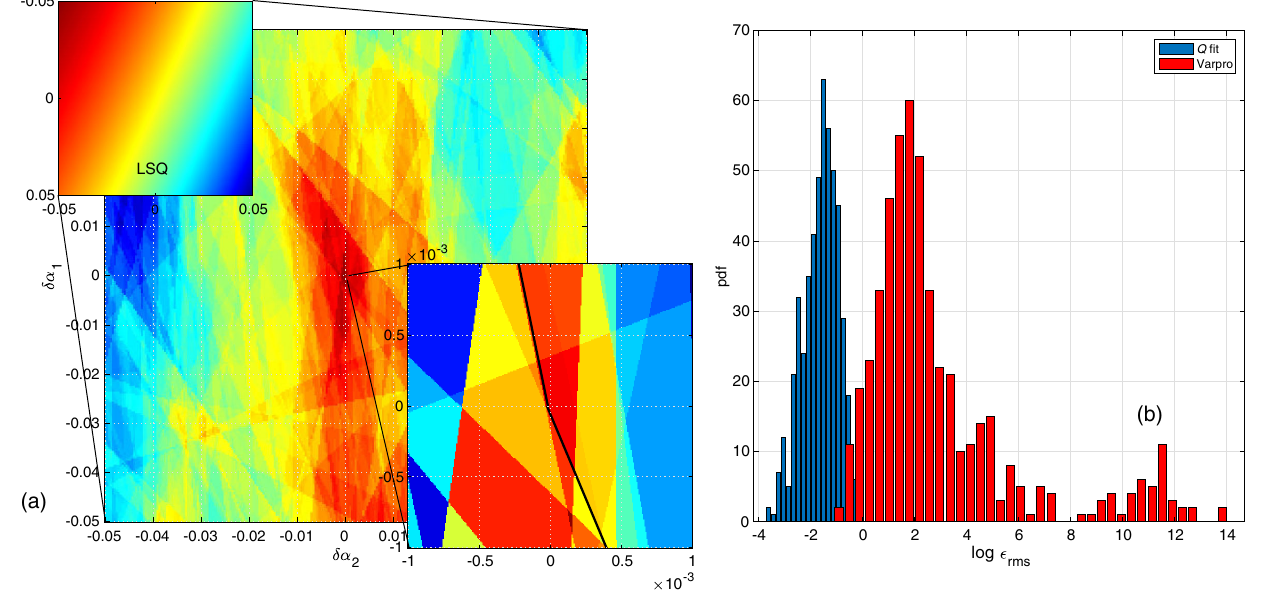
FIG. 12. Q optimization of the decay exponents. (a) The main image shows 1 =Q for the single realization above [maxima (red) are rms rms more readily visible than minima (blue)], plotted in the ð α 1 ; α 2 Þ plane and centered about the exponent pair listed in Fig. 11(a). The discreteness of rank creates this mosaic: a palimpsest of wedges. The Nelder-Mead simplex method is suitable here, but in a given search, it gets trapped by one of many nearly identical local minima. Zooming in around the origin × 50 shows the simplex vertex where the algorithm converged, but almost directly below this point, we see a tiny simplex that (slightly) exceeds this maximum. (Color for the inset is rescaled.) To the upper left is a plot for the entire region of the reciprocal of the conventional LS error, with no local maximum at all. Rather, for this ð c 1 ; c 2 Þ pair, the global LS maximum is at α 1 ¼ − 2 . 699 and α 2 ¼ − 3 . 055 , significantly worse and far out in the tail of the dotted pdf of ≡ j v − v Fig. 11. (b) Regarding the unknowns as a four-vector v ¼ ½ c 1 ; c 2 ; α 1 ; α 2 (cid:3) , with the exact solution denoted by v 0 , we compute ϵ 0 j rms for V arpro and Q fits in a Monte Carlo simulation of 500 trials. Only about 5% of the former lie to the left of the worst single Q